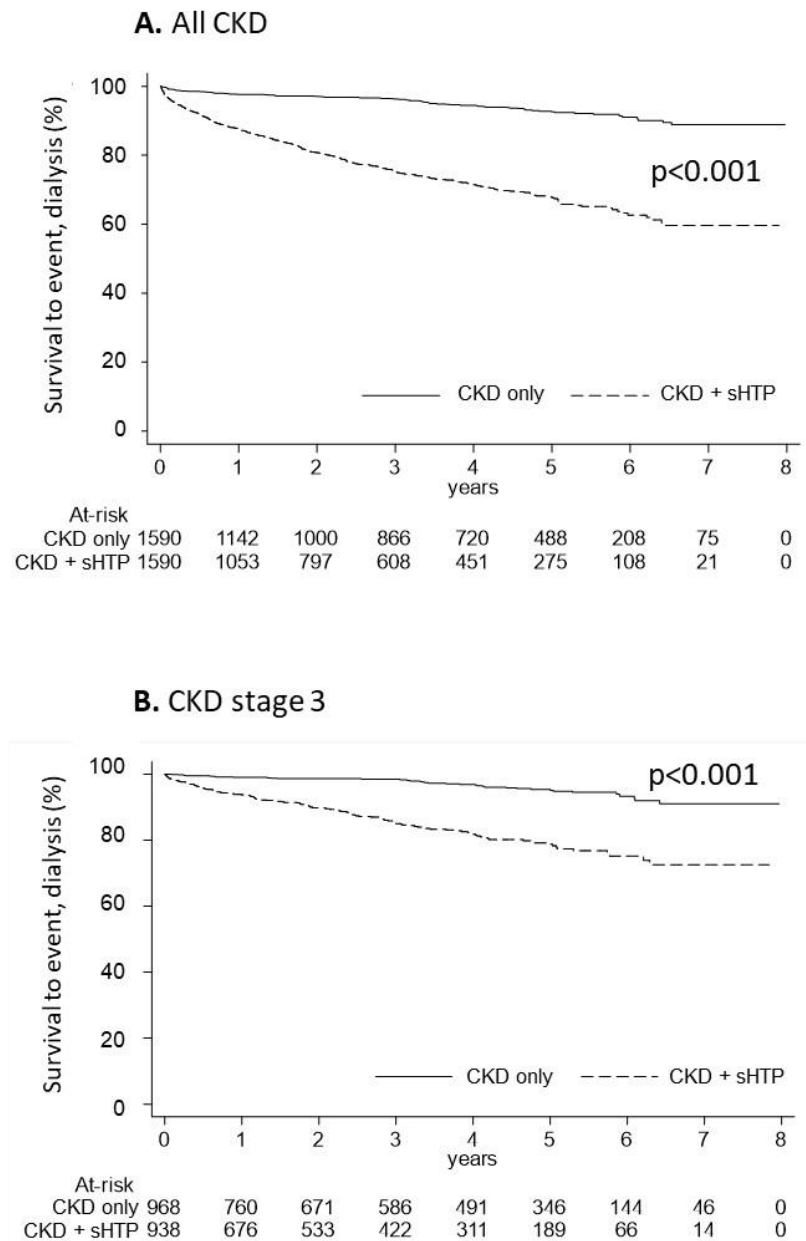
Figure 3. Kaplan-Meier curves for the CKD + sHPT vs. CKD only groups showing survival to the event (dialysis) in all CKD patients ( A ) and in those with CKD stage 3 ( B ). The Kaplan-Meier curves used to estimate cumulative mortality showed that overall survival was significantly lower ( p < 0.001) in the CKD + sHPT versus CKD-only group (incidence rate: 217.98 in CKD + sHPT and 180.04 in CKD patients) (Figure 4A). This difference was also evident for patients at stage 3 (incidence rate: 215.61 in CKD + sHPT and 151.69 in CKD patients) (Figure